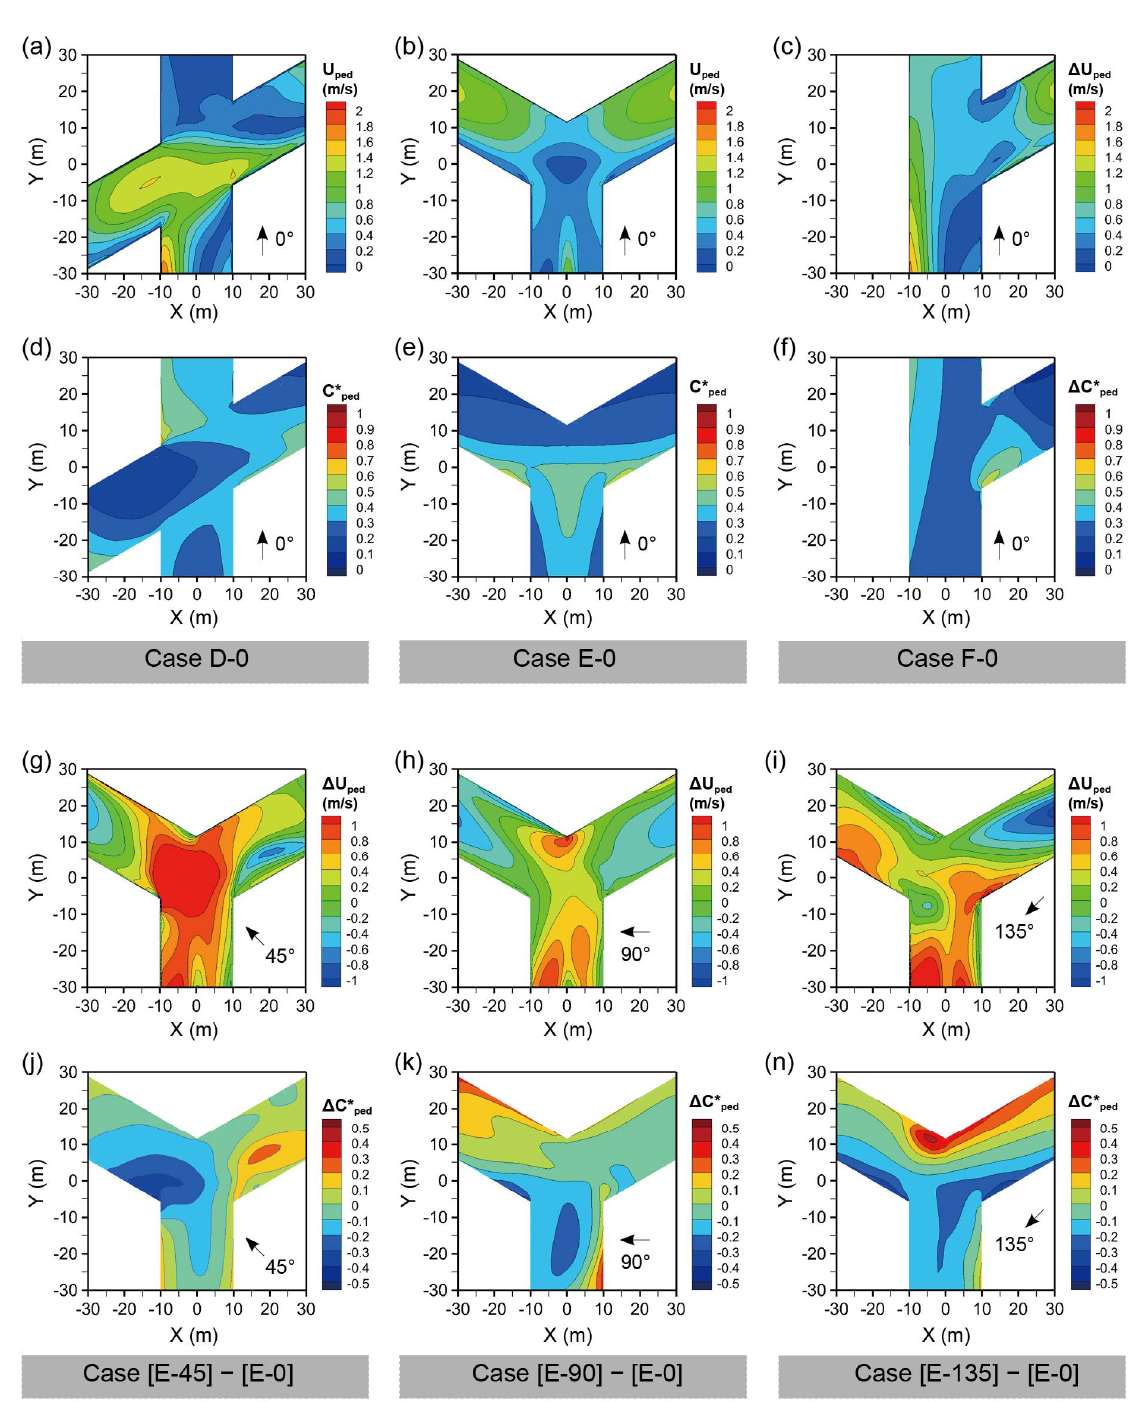
Figure 10. Wind velocity (U) and normalized pollutant concentration (C ∗ ) at Z = 1.5 m for Cases ( a , d ) D-0, ( b , e ) E-0, and ( c , f ) F-0; the difference of wind velocity and normalized pollutant concentration for ( g – n ) Case E, taking Case E-0 as the control